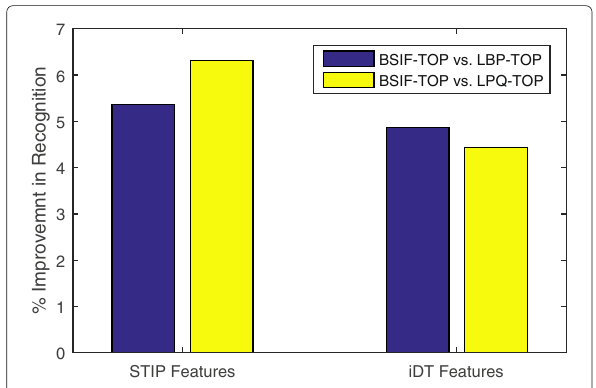
Fig. 8 Percentage improvement of BSIF-TOP over LBP-TOP and LPQ-TOP, when combined with trajectory based features on